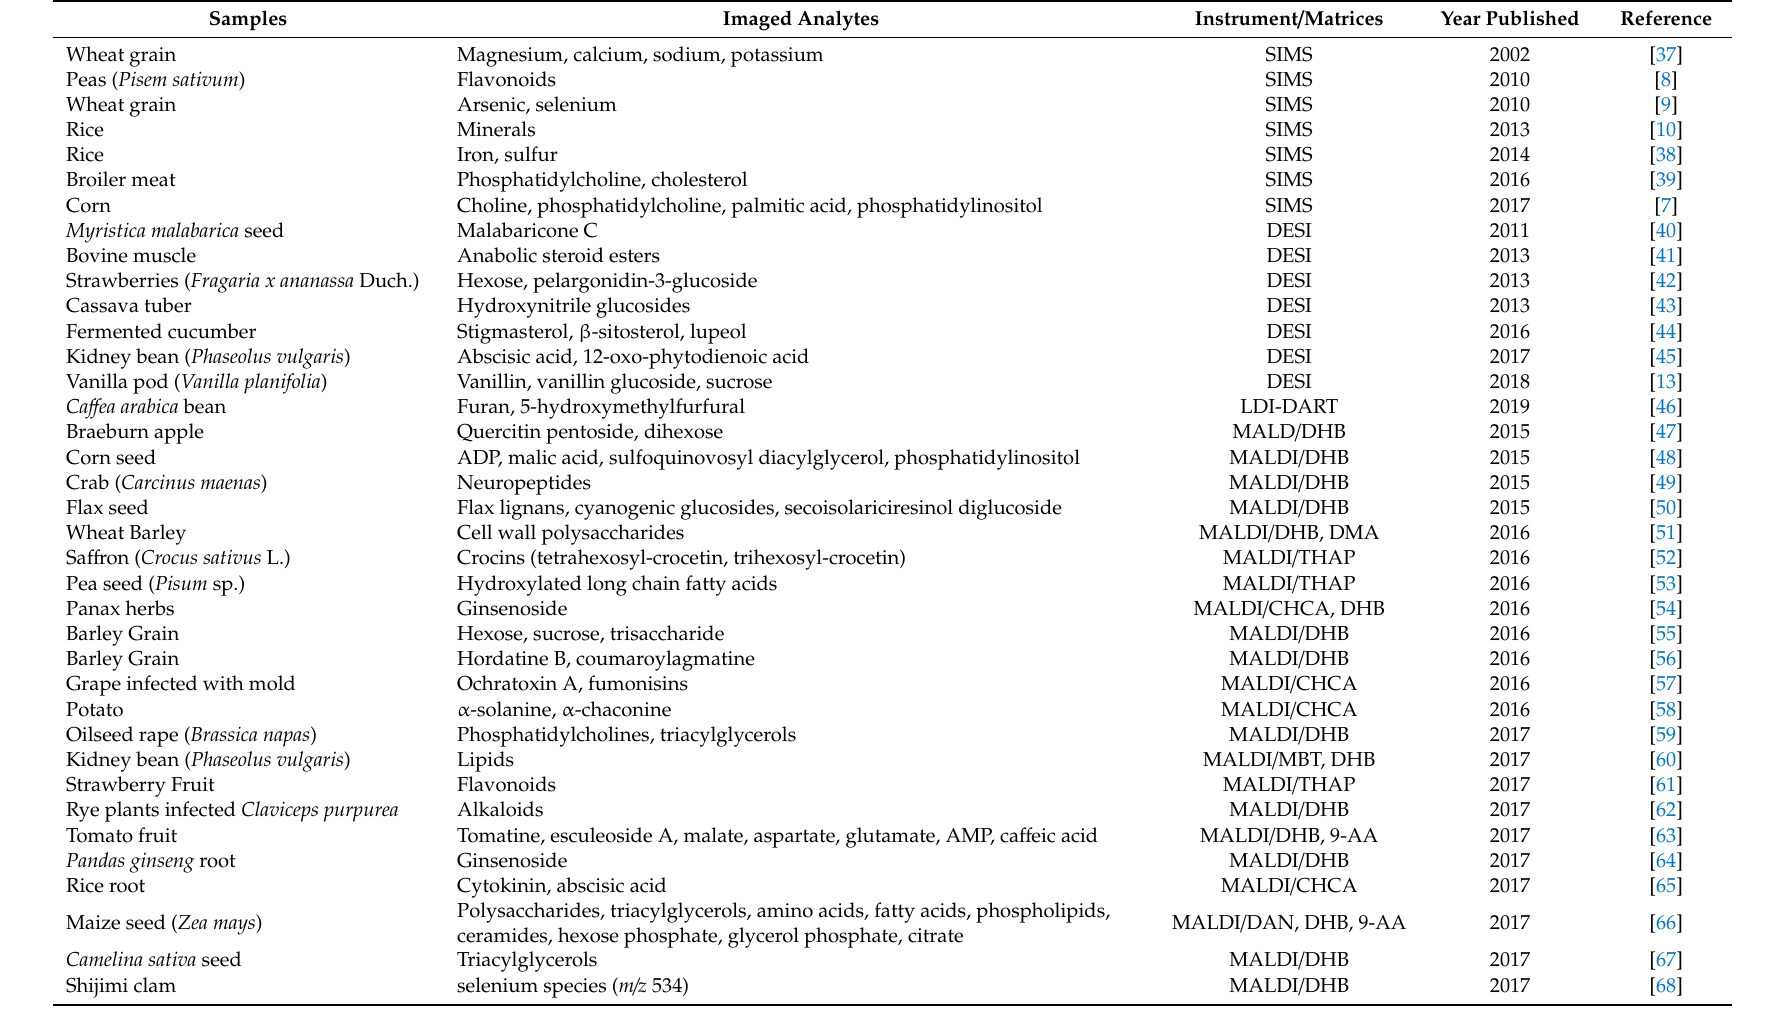
Table 3. Overview of the application of MSI for imaging of food